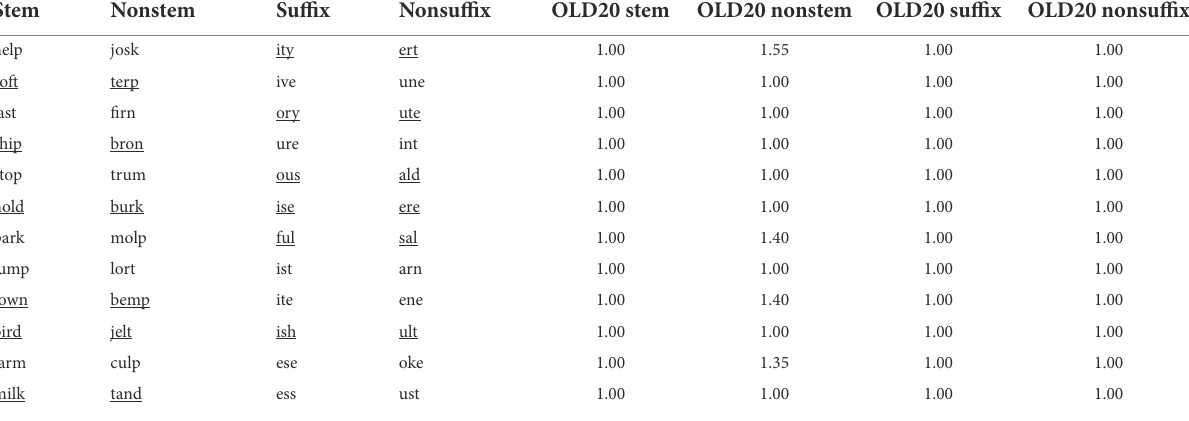
TABLE 1 Unique stems, nonstems, suffixes, and nonsuffixes combined to generate nonword stimuli, and the respective OLD20 statistics. All listed items were used to construct stimuli in the study with adults, while a subset (underlined items) was used to construct stimuli for the study with children. The full sets of stimuli are reported in the Supplementary Tables S1,